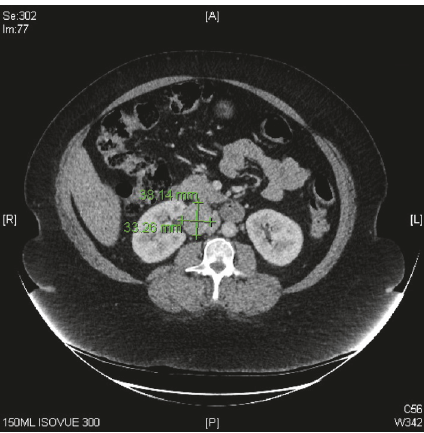
Figure 1: CT abdomen/pelvis with